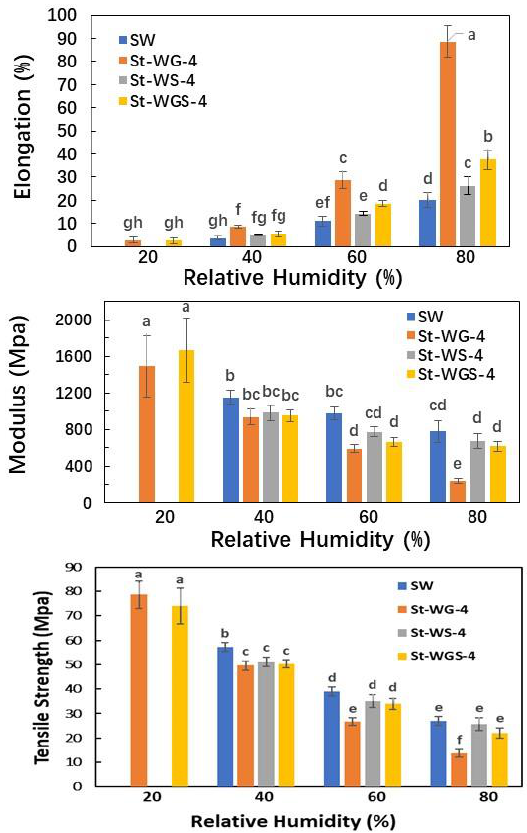
Figure 2. Effect of humidity conditions on the tensile properties of a starch film plasticized with different and multi-plasticizers. The results were statistically analyzed by ANOVA and marked as abcdefgh.